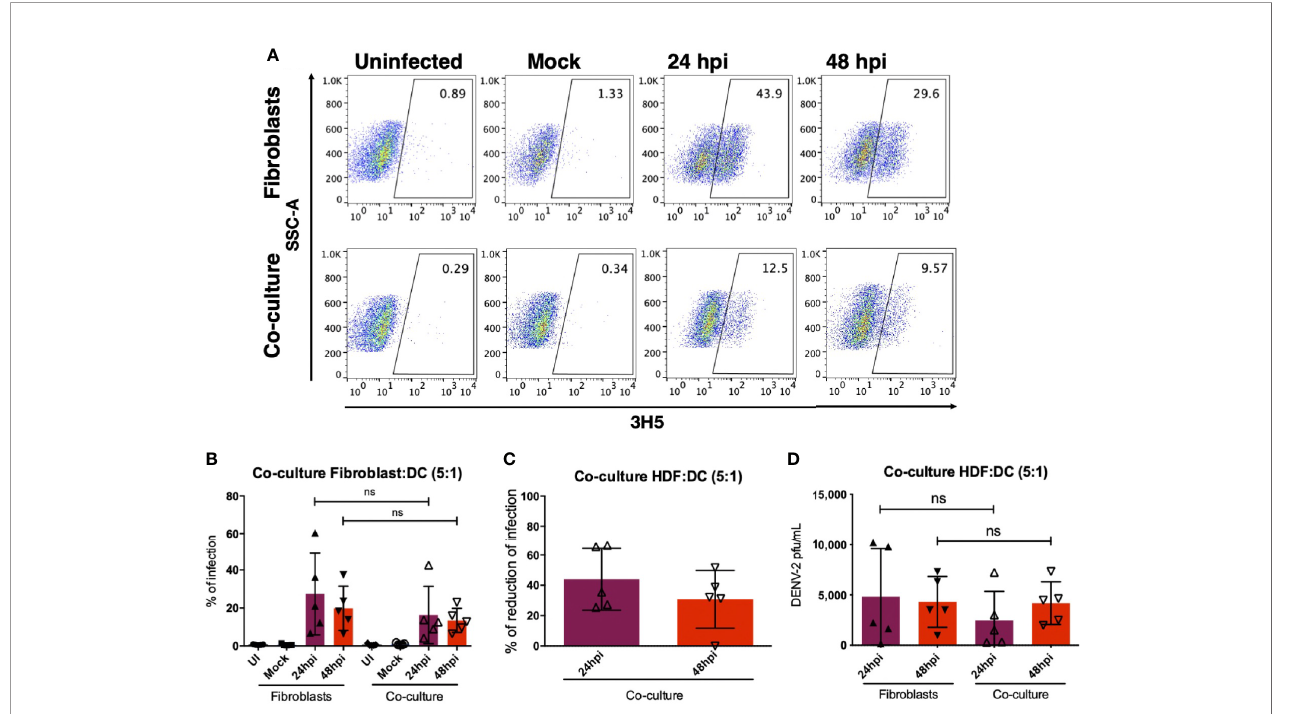
FIGURE 6 | Dendritic cells promote control of DENV-2 infection by fi broblasts. Dermal fi broblasts alone or in coculture with autologous moDC in a 5:1 ratio were infected with DENV-2 for 24 and 48 hours, and then infection was evaluated based on the expression of the envelope protein using fl ow cytometry. (A) Representative dot plot of one donor showing the infection rate in monoculture and coculture. (B) Percent of DENV infected cells in the coculture and monoculture conditions. (C) Reduction of the infection based on the maximum infection rate of the monoculture infections. (D) Analysis of plaque forming units in the supernatants of infected cultures. Error bars indicate the standard deviations for the three independent experiments of each donor; n = 5. ns, no signi fi cant.